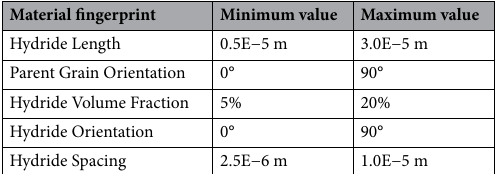
Table 3. Hydride microstructural